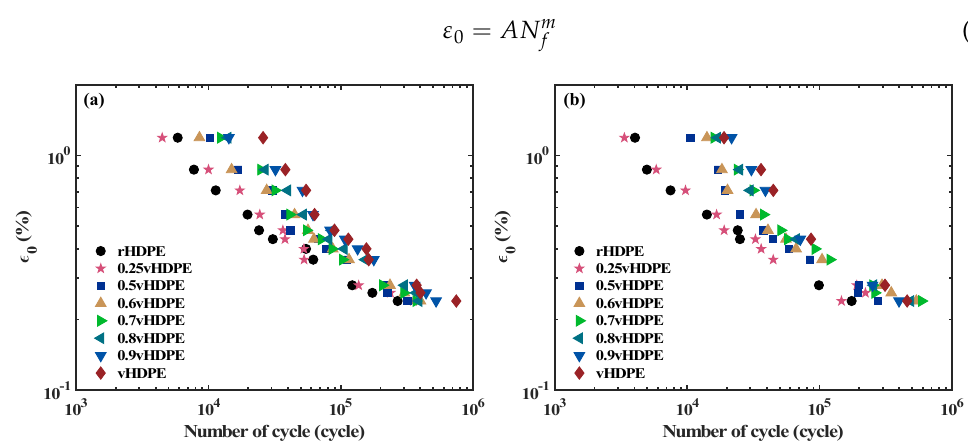
Figure 6. Strain – life curves of the rHDPE/vHDPE blends for both processing methods: ( a ) powder mixing and ( b ) extrusion mixing. Table 2. Fitting parameters ( m , m’ and A ) of the Wöhler curves for powder mixing (PM) and extru- sion mixing (EM).